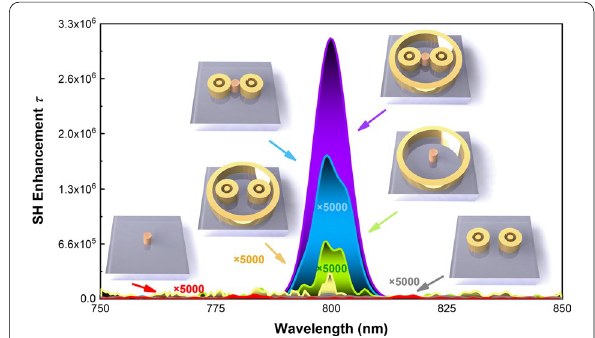
Fig. 5 SHG enhancement of four different structures. Insets show corresponding schematics, including pure MoS 2 nanoparticles, paired bull-eye rings without MoS 2 , hybrid metasurface without MoS 2 , wall ring structure, paired bull-eye rings, and hybrid